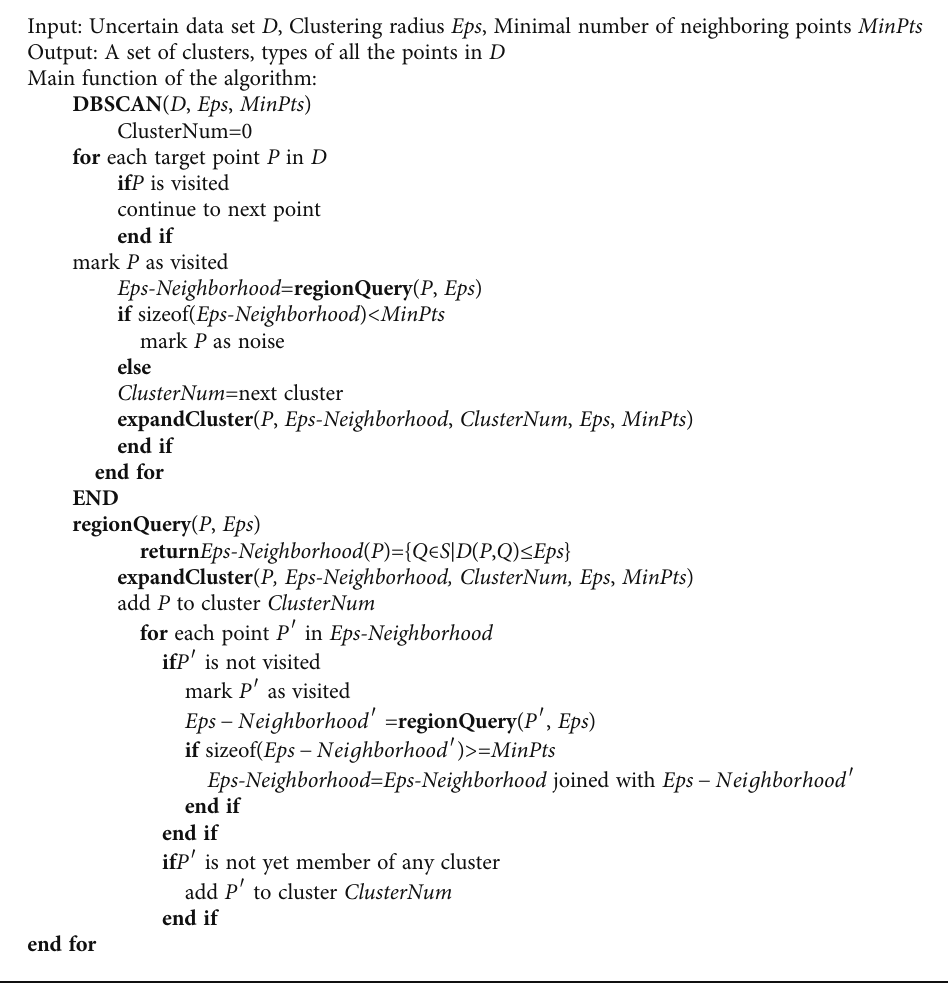
Algorithm 1: DBSCAN algorithm fl ow. Table 1: Destination position.